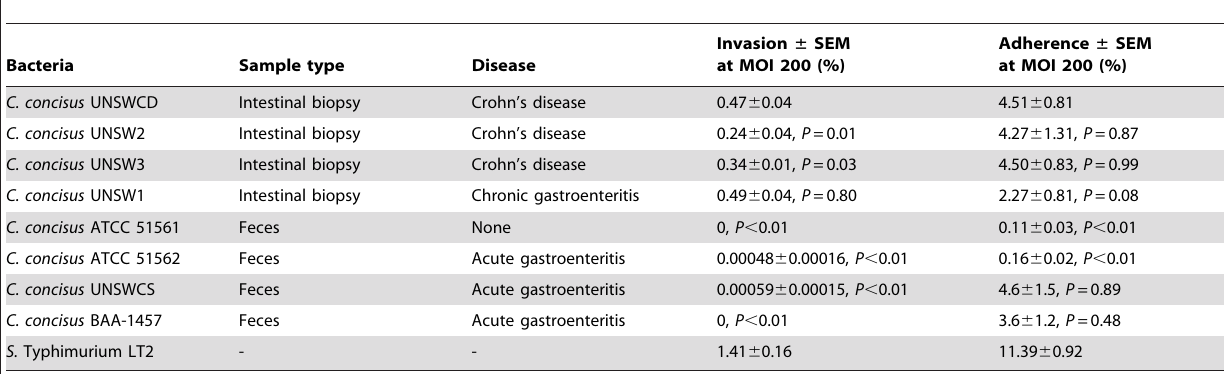
Table 2. Comparison of the percentage invasion and adherence into Caco-2 cells of eight Campylobacter concisus strains.